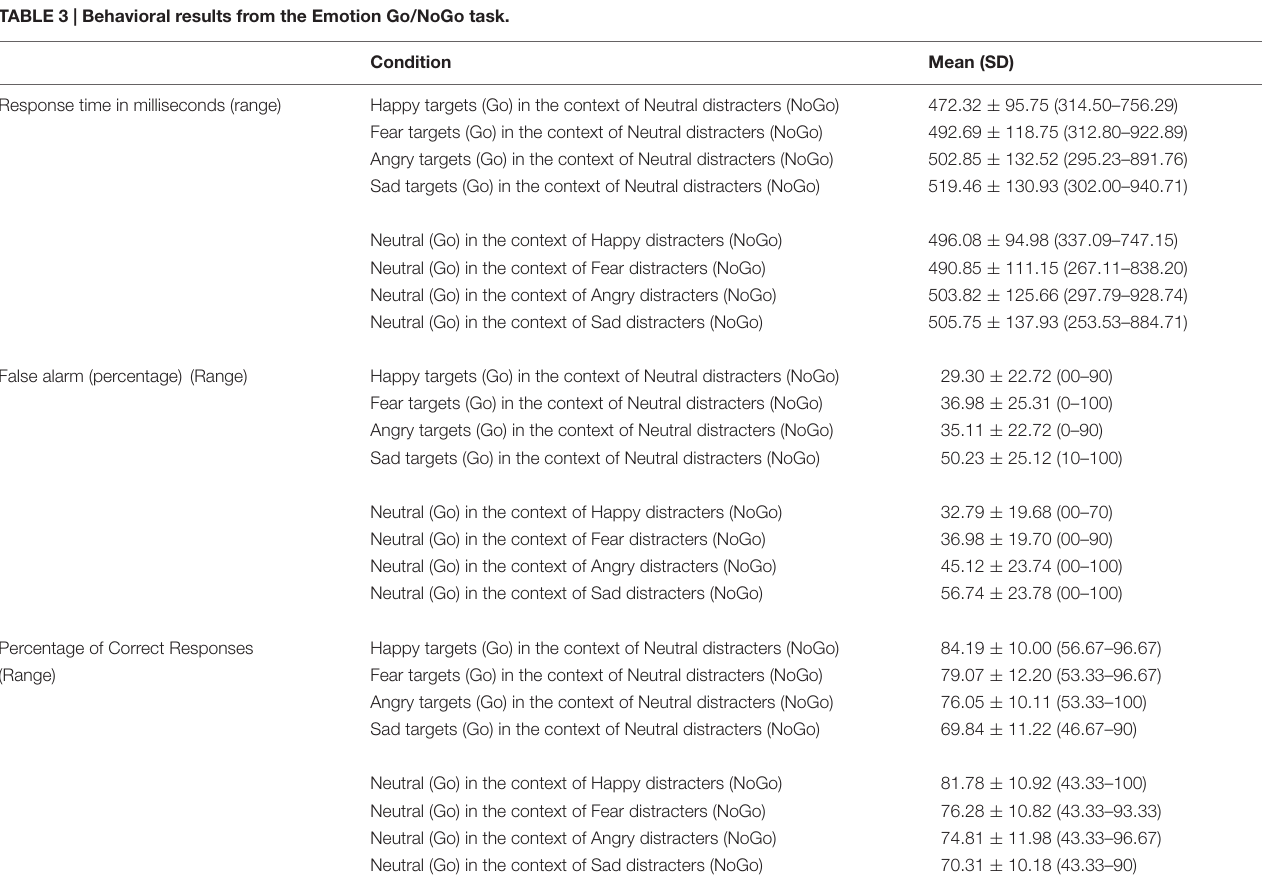
TABLE 3 | Behavioral results from the Emotion Go/NoGo